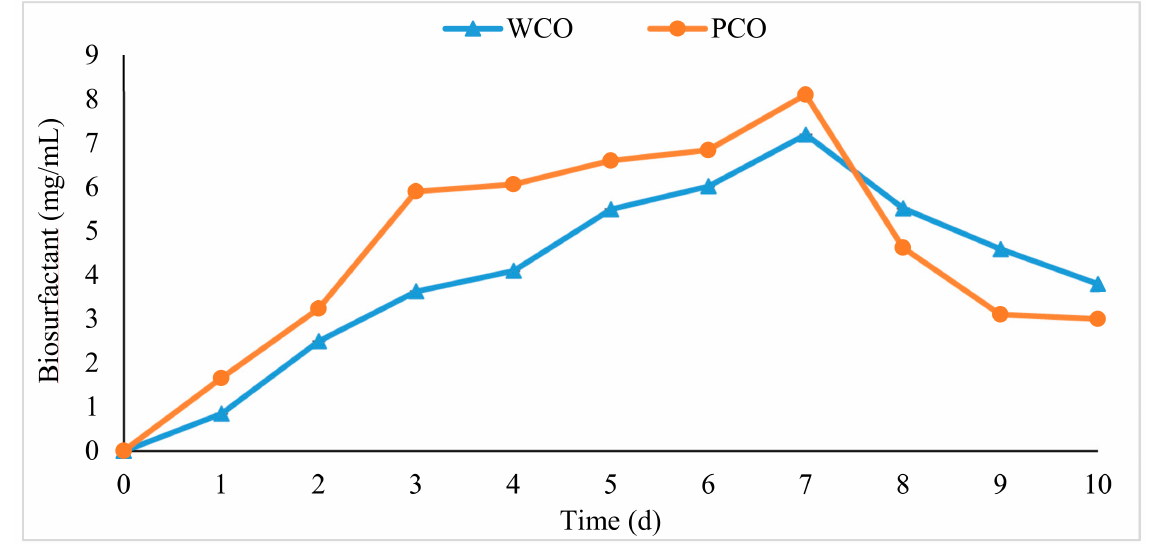
Figure 7. Biosurfactant production over a 10 days incubation by BS14 bacterial consortium. Error bars represent mean ± standard error (SEM) and are contained within the